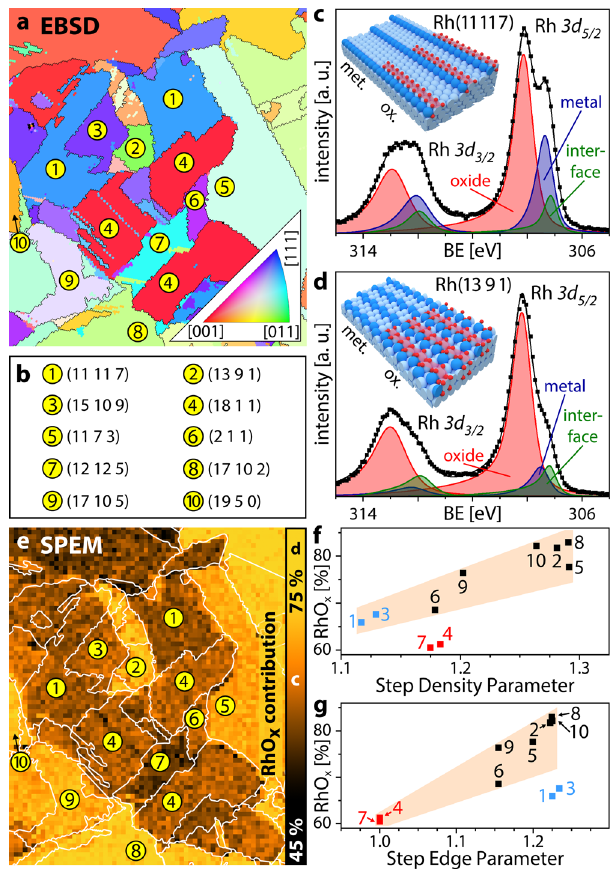
Fig. 2 Mapping anisotropic Rh surface oxidation. a EBSD image of the polycrystalline Rh foil (512 ×600 µ m); b crystallographic orientations (Miller indices) of the Rh(hkl) domains indicated in a and e ; c , d examples of local XPS spectra and ball models of the metallic and oxidised Rh(11 11 7) and Rh (13 9 1) domains, respectively. Squares: measured values; solid lines: sum of the deconvoluted components; e oxidation map of the region displayed in a after oxidation in O 2 ( T = 623K, pO 2 = 2.5×10 − 4 mbar, t = 90min), with the right edge of the map displaying the colour scale for the RhO x contribution; f , g show the RhO x contribution versus the step density parameter (SDP) and step edge parameter (SEP), respectively (see SI for a detailed description of SDP and SEP). Squares: measured values (see text for the highlighted data points); shaded areas serve as a guide for the